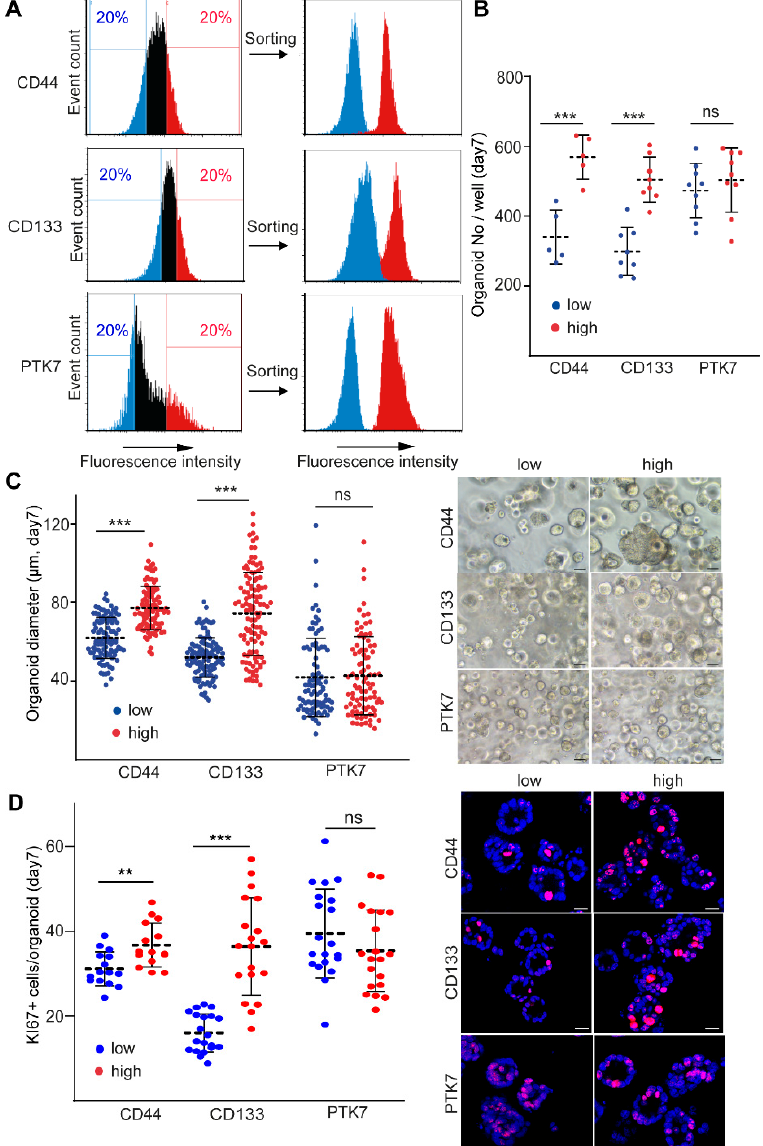
Figure 2. CD44 high and CD133 high cell-derived organoids have more proliferating cells as compared to CD44 low and CD133 low organoids. ( A ) Sorting strategy and the level of CD44, CD133, and PTK7 in the sorted populations. ( B ) Number of organoids produced from cells sorted for low and high levels of the respective markers, counted on day7 (1–2 sorting experiments from organoid lines #1–#4). ( C ) The diameter of the organoids 7 days after seeding the sorted cells into Matrigel. ( D ) The percentage of KI67+ proliferating cells in the organoids (confocal microscopic images). For C and D, quantification (left panel) and representative images (right panel) are shown (two sorting experiments from four organoid lines). Scale bars: 25 µm ( C , D ). Mann–Whitney U test was used ( B – D ). ** p < 0.01, and *** p < 0.005.